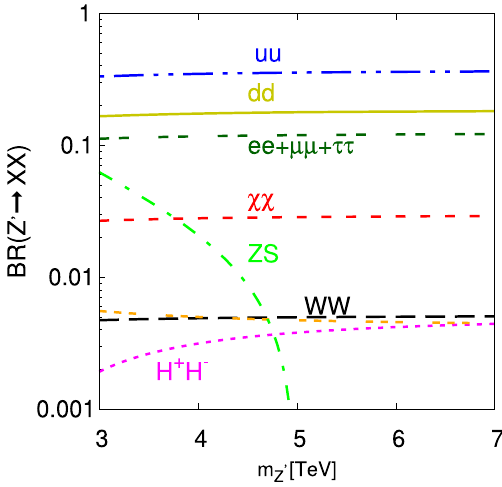
Fig. 6 Relevant branching ratios of Z (cid:2) gauge boson as a function of its